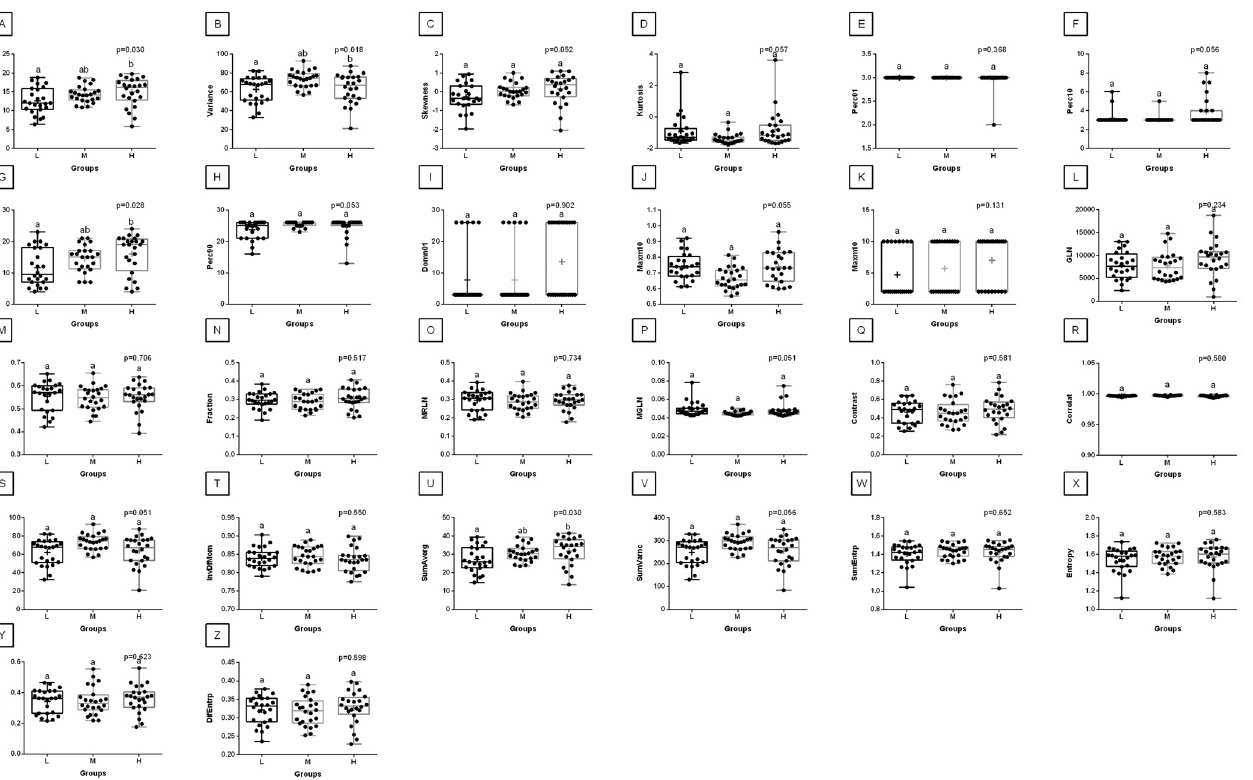
Figure 10. Analysis of texture features for the green component compared between light (L), moder- ate (M), and heavy (H) groups in the third region of interest (ROI 3). Differences between groups were indicated with individual p -values when p < 0.05. Different superscripts on each plot were statistically different. ( A ) Mean; ( B ) Variance; ( C ) Skewness—skewness coefficient; ( D ) Kurtosis; ( E – H ) Perc01, Perc10, Perc50, Perc90—percentiles; ( I , K ) Maxm01, Maxm10—maximum of moments; ( J ) Domn01— dominant; ( L ) GLN—gray level non-uniformity; ( M ) SRE—short-run emphasis; ( N ) Fraction— a fraction of image in runs; ( O ) MRLN—run-length nonuniformity moment; ( P ) MGLN—gray level non-uniformity moment; ( Q ) Contrast; ( R ) Correlat—correlation; ( S ) SumOfSqs—sum of squares; ( T ) InvDefMom—inverse different moment/homogeneity; ( U ) SumAverg—summation mean; ( V ) SumVarnc—summation variance; ( W ) SumEntrp—summation entropy; ( X ) Entropy; ( Y ) DifVarnc—differential variance; ( Z ) DifEntrp—differential entropy. Data are presented using minimum and maximum values, lower and upper quartiles, and median. The mean value is marked by a